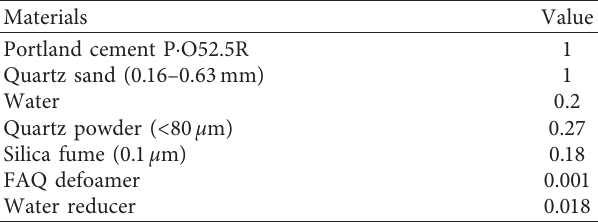
Table 1: Mix proportion of the mortar.